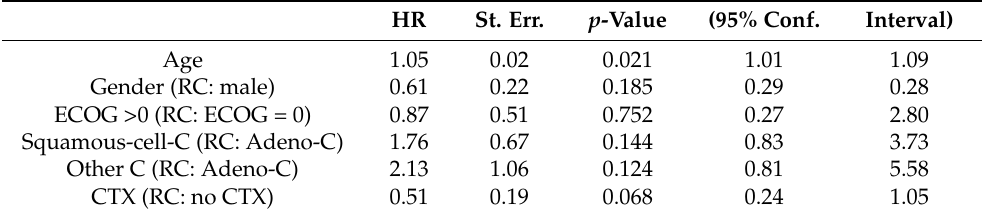
Cox Regression analysis of the T3b subgroup. Patients with adjuvant radio– chemotherapy/radiotherapy are excluded.